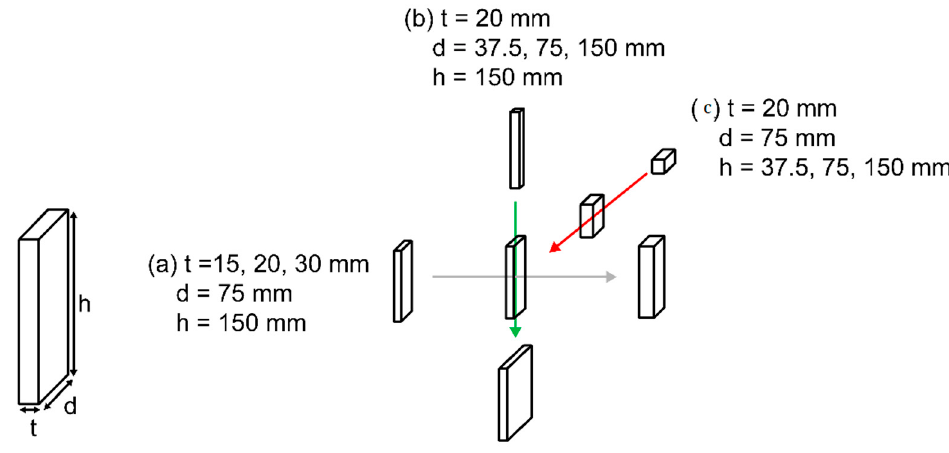
Figure 4. Measurement parameters:( a ) thickness (t) ; ( b ) depth (d) ; ( c ) height (h) variation. Thus, seven steel plates of different dimensions were obtained. For each set of measurements, one parameter was varied, and the other two were kept constant. Each plate was placed inside a mortar specimen with dimensions of 150 mm × 150 mm × 225 mm (Figures 5 and 6).